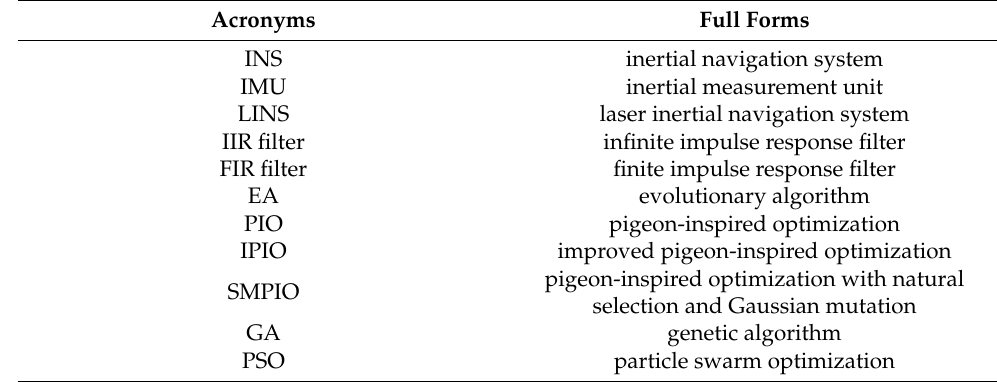
Table 1. The main abbreviations of this article. Acronyms Full Forms